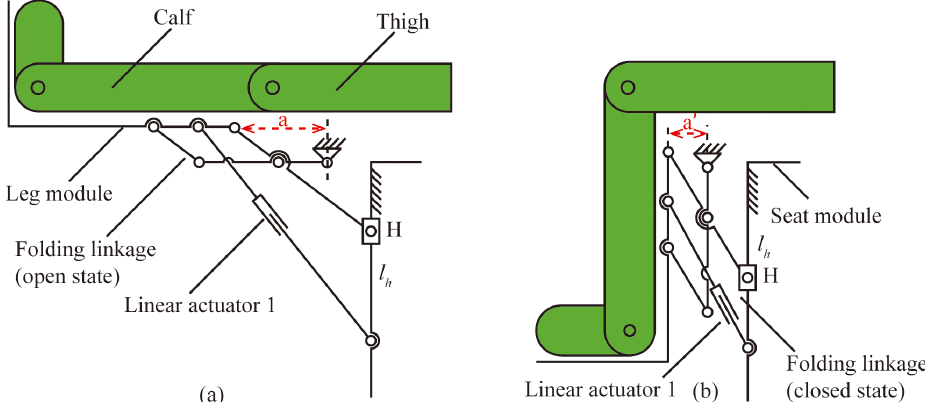
Figure 6. The configuration of the leg module with configuration III. (a) Schematic diagram of the leg module at the lying posture. (b) Schematic diagram of the leg module at the sitting